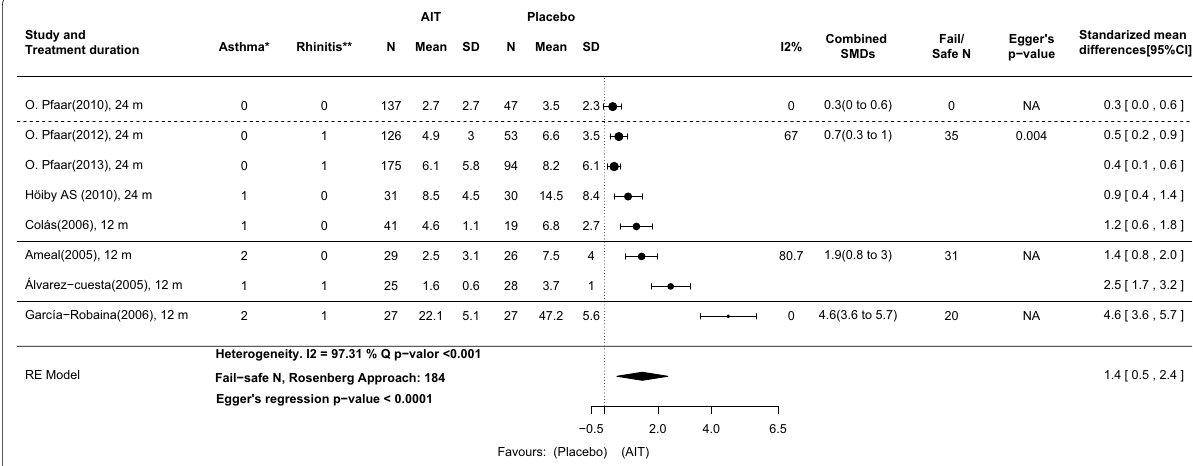
Fig. 4 AIT with DPAEs compared with placebo at the time of primary analysis in original studies. Outcome: combined symptom and medication score (cSMS) calculated with daily measures from CSR. Four subgroups of asthma and rhinoconjunctivitis severity are delimited by solid and dashed lines. *Asthma classification: (0) Only intermittent asthma patients included; (1) Intermittent to mild persistent asthma patients included; (2) Intermittent to moderate persistent asthma patients included. **Rhinoconjunctivitis classification: (0) Any rhinoconjunctivitis severity included; (1) Moderate to severe rhinoconjunctivitis included. 95%CI: 95% confidence interval; m months, SD standard deviation, SMDs standardized mean